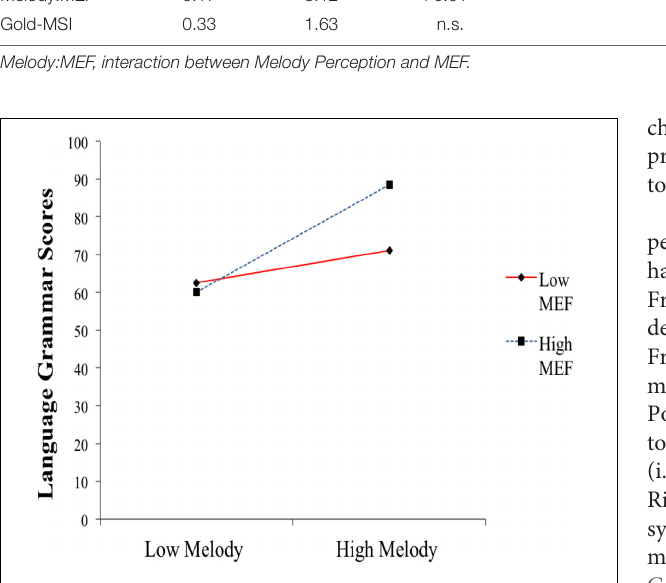
Anvari et al., 2002; Verney, 2013; 8- to 13-year-olds: Huss et